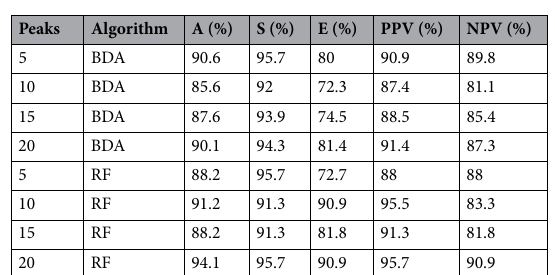
Figure 2. Unsupervised statistical analysis. ( a ) Hierarchical k-means clustering (Hkmc)-Principal Component Analysis (PCA) cluster plot using the top ten peaks selected by the binary discriminant analysis (BDA) algorithm. Labels contain the mice ID and the experimental groups. PC1 (Dim1, x-axis) and 2 (Dim2, y-axis) are depicted. Spectra were clustered into three groups using the Hkmc algorithm, which are represented with three different colors. 95% confidence ellipses were added around cluster means, assuming a multivariate normal distribution. ( b ) Hkmc-PCA cluster composition. The green color represents the CTL mice group, the blue represents the IS group, and the red color represents the LPS group.